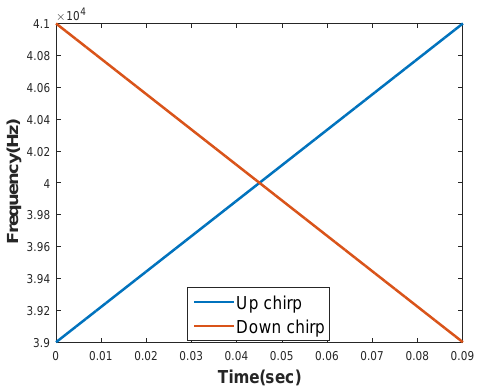
Figure 1. Illustration of up and down chirp rates for two signals with 39–41 kHz/9 ms and 41–39 kHz/9 ms chirp